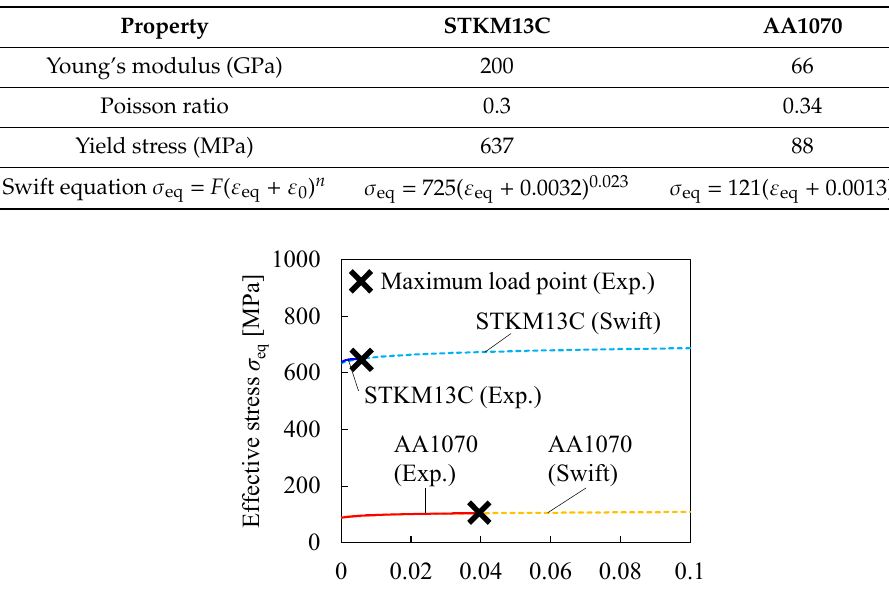
Table 2. Material properties of tube materials (FEM).